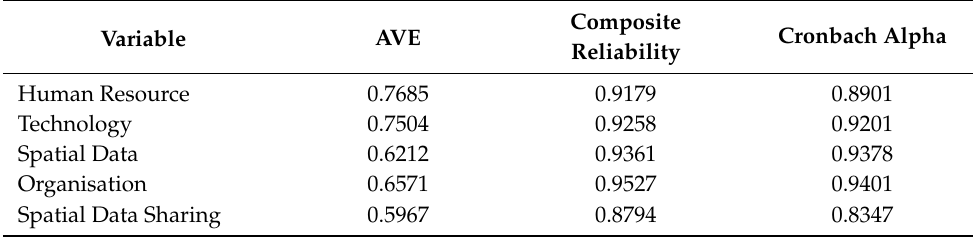
Table 8. The average variance extracted (AVE), Cronbach alpha and composite reliability.